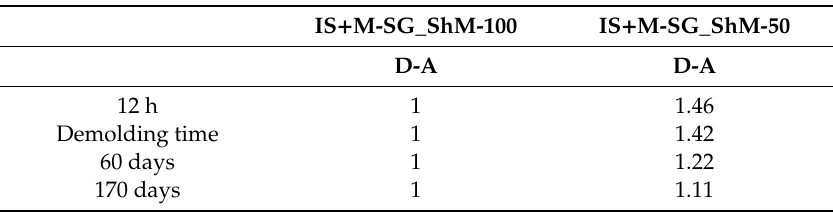
Table 5. Shrinkage values of the SCC HPC: Relative average values of shrinkage determined for di ff erent size of the specimens.